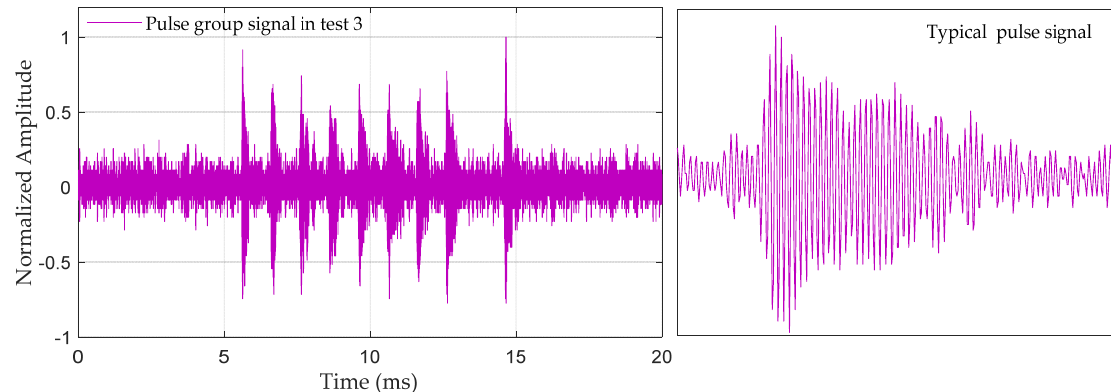
Figure 14. eLoran signal collected in Test 3.